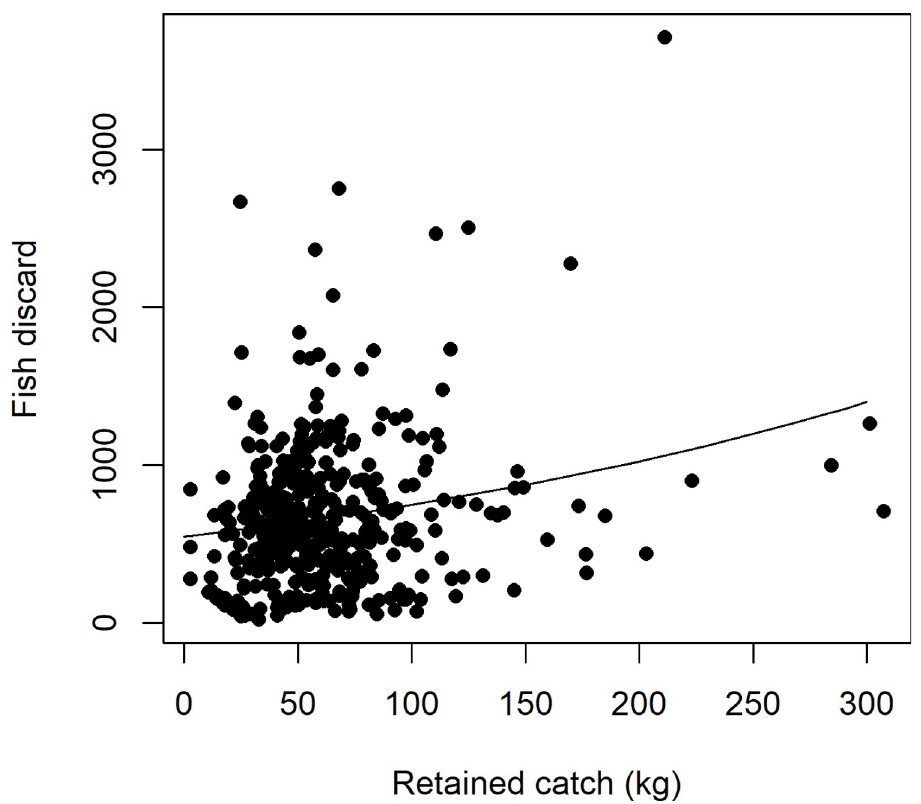
Fig 7. Relationship between log standardised count of discarded fish and net haul level weighted mean of retained